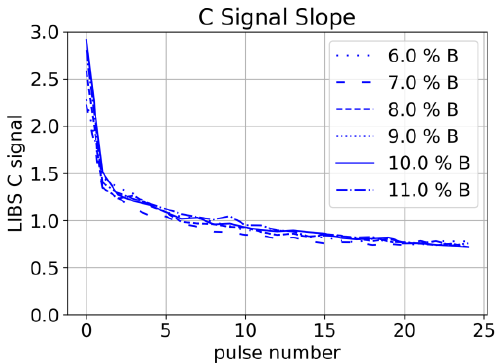
Figure 11. Slope of C signal (193 nm line) for subsequent pulses at the same measurement spot for samples with different Binder concentrations (each sample: mean of 25 spectra).